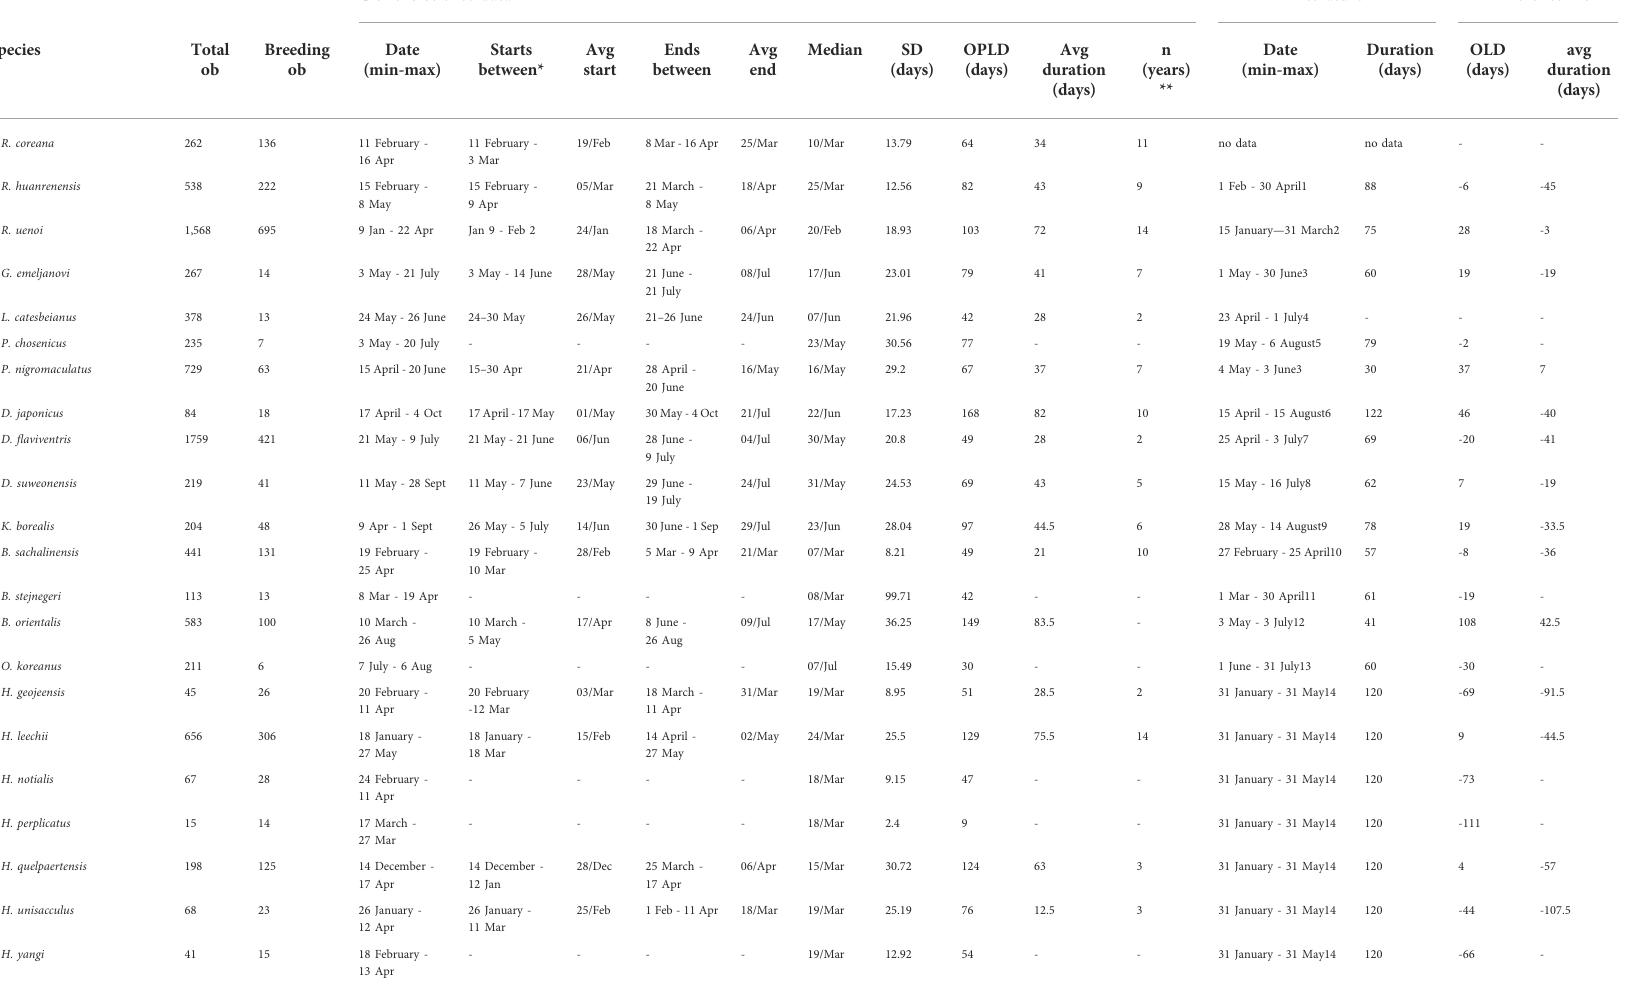
TABLE 1 Breeding phenology start/end dates, min and maximum duration, overall longest duration (OLD), and average durations based on citizens science data and the widest duration in literature. Also, the days difference in duration of the OLD and average breeding phenology between citizens science and literature (minus is days less in citizens science data compared to literature). Lithobates catesbeianus is invasive in Korea and breeding data from literature is from native range, and the data for Bufo stejnegeri is for the oviposition period only. The analysis is based on 8,763 citizen science observationscollectedbetween02March1997and01December2020downloadedfromtheplatformiNaturalist.*asthe fi rstbreedingdatechangesfromyeartoyear,thisrepresentstherangewhenthe species start breeding. ** Years with more than three datapoints and used to calculate the starts/end periods and average